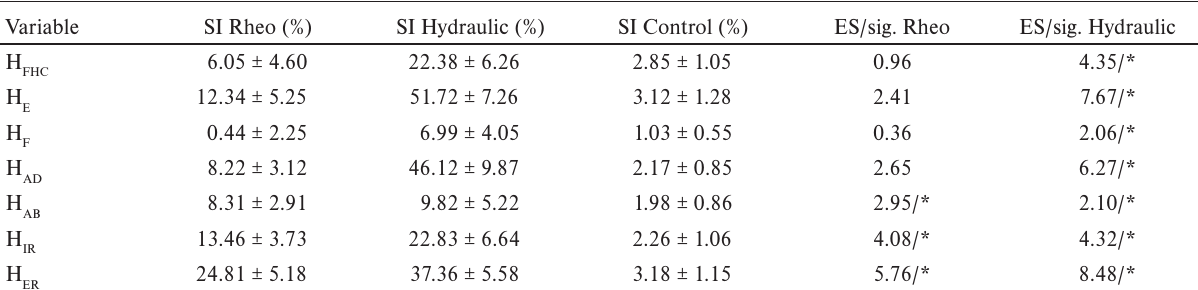
Symmetry indexes for hip joint angles for bionic knee joints (SI Rheo), hydraulic knee joints (SI Hydraulic) and the control group (SI